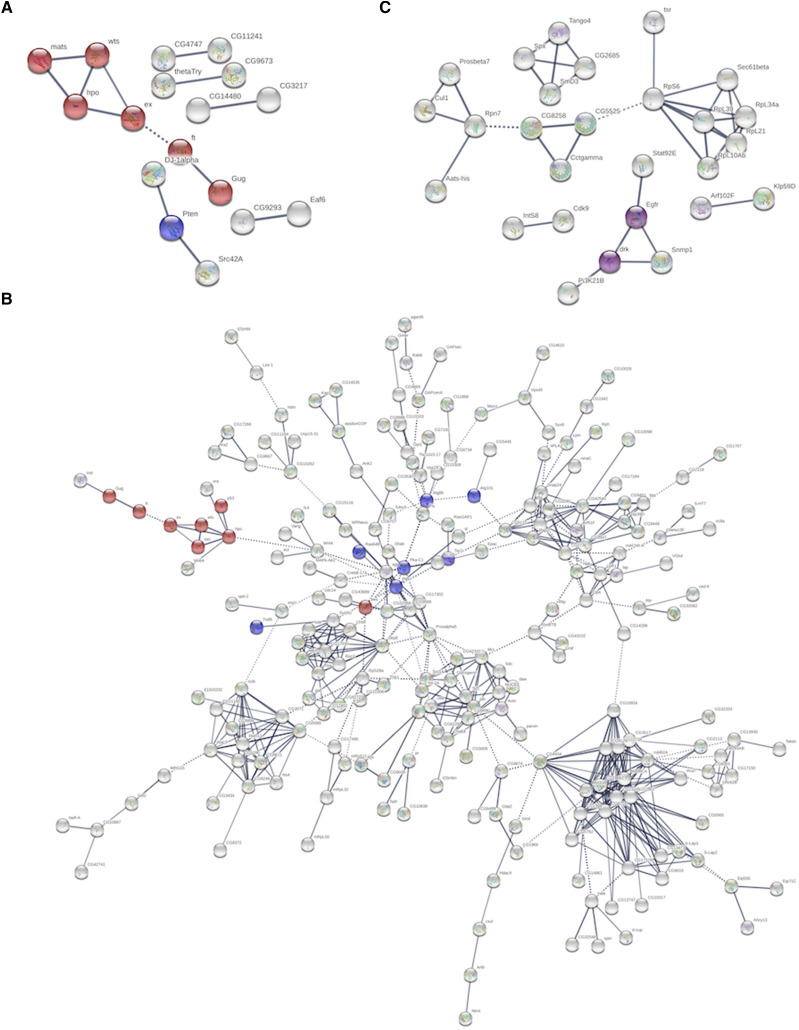
STRING interactome analysis of potential interactors of EGFR and YKi in Drosophila. STRING analysis was performed with confidence score of 0.7 and MCL clustering value of 2. (A) STRING Interactome of 73 fly genes identified as potential negative regulators in the context of over expression of EGFR. 17 out of those formed molecular clusters (with PPI enrichment value of 0.000482), largest being a cluster of 6 genes, all of which are constitutes of Fat/Hippo pathway (shown in red; FDR-1.39E-5). (B) STRING Interactome of 888 genes of identified as potential negative regulators in the context of over expression of Yki. 228 of those formed a single cluster with PPI enrichment value 1.4E-06. Components of Fat/Hippo pathway (red: FDR-0.00076) and Autophagy genes (blue: FDR-0.0241) are enriched in this cluster. (C) STRING Interactome of 32 fly genes identified as potential oncogenes in the context of SOCS suppression. 27 out of those formed molecular clusters (with PPI enrichment value of 0.0122), largest being a cluster of 14 genes. A smaller cluster comprising of EGFR and DrK were enriched in Dorso-ventral axis formation (shown in purple: FDR-0.0089).